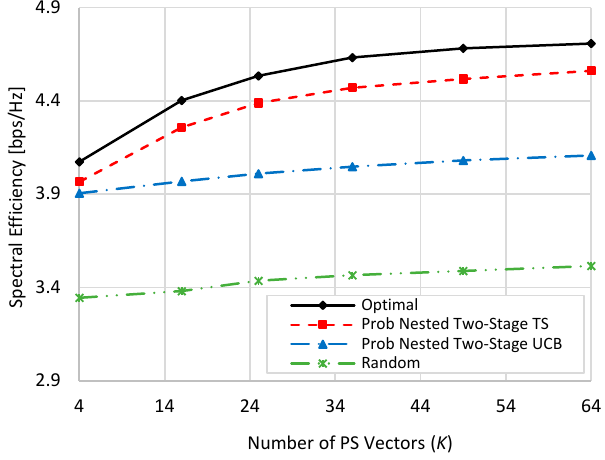
Figure 4. Spectral efficiency against the used number of PS vectors when N = 36 and M = 64 at zero blockage.